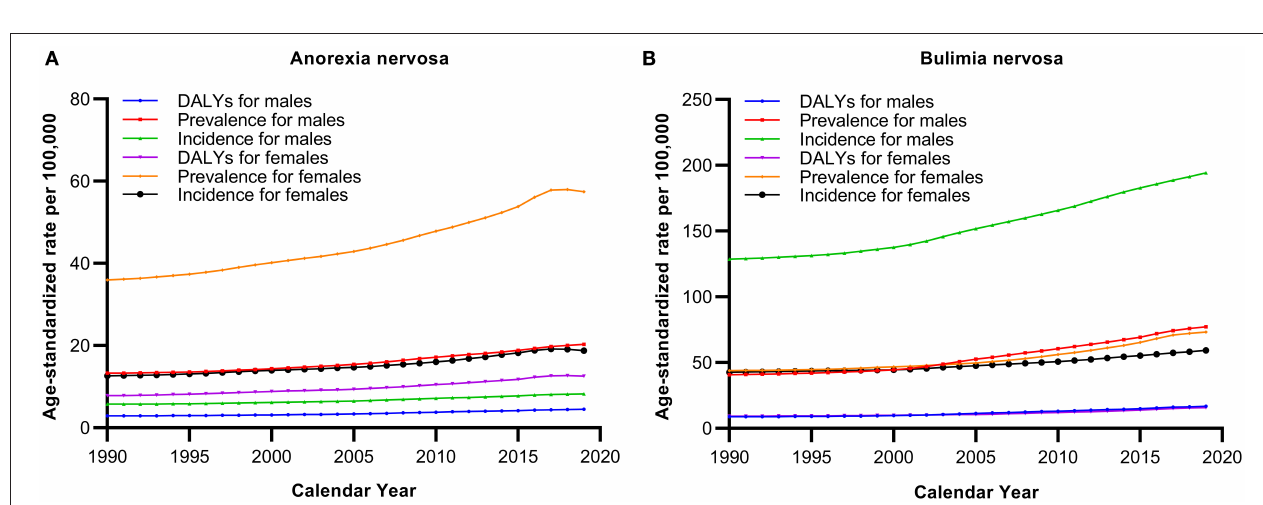
FIGURE 2 | Trends in age-standardized prevalence, incidence, and DALY rates of anorexia nervosa (A) and bulimia nervosa (B) in China from 1990 to 2019.